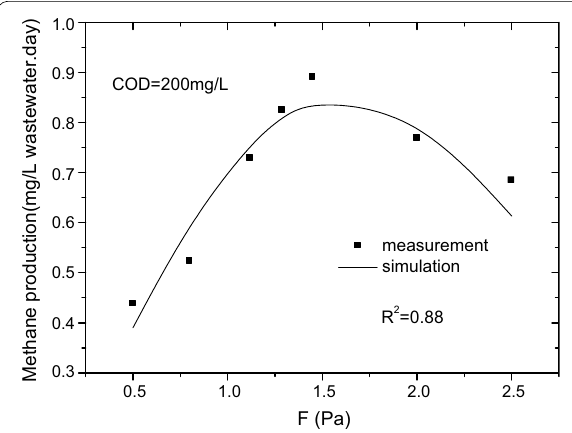
Fig. 9 Methane production vs wall-shear stress, COD The relationship between the methane production and wall-shear stress. The R 2 value of Eq. (5) was 0.95, indicating that the Eq. (5) was also reasonable